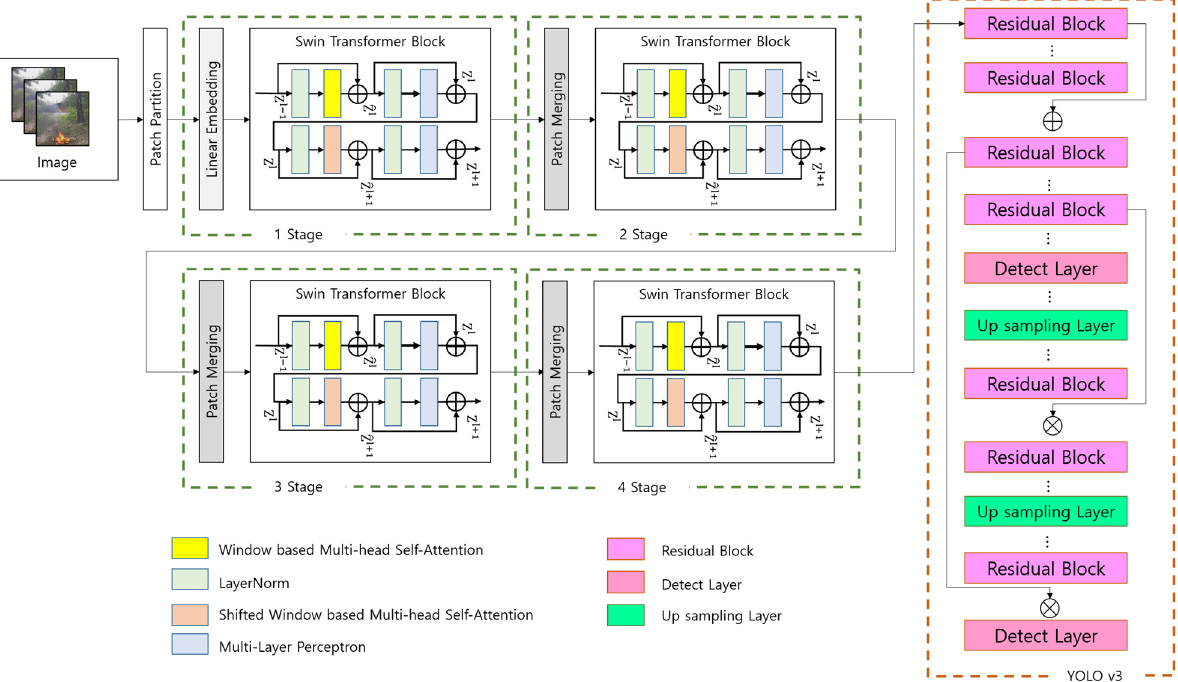
Figure 5. The architecture of the Swin Transformer ‐ based object detection model.